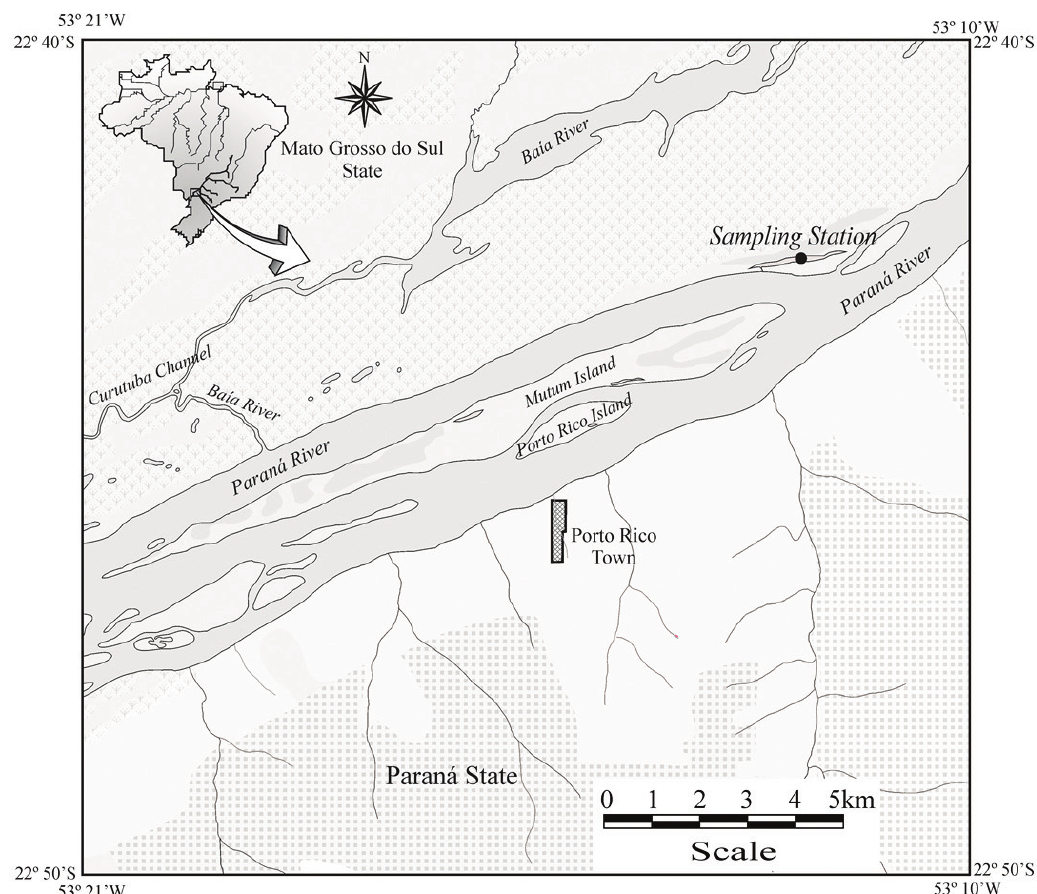
Figure 1. Map showing the location of the sampling station in the floodplain lake, in the Upper Paraná River